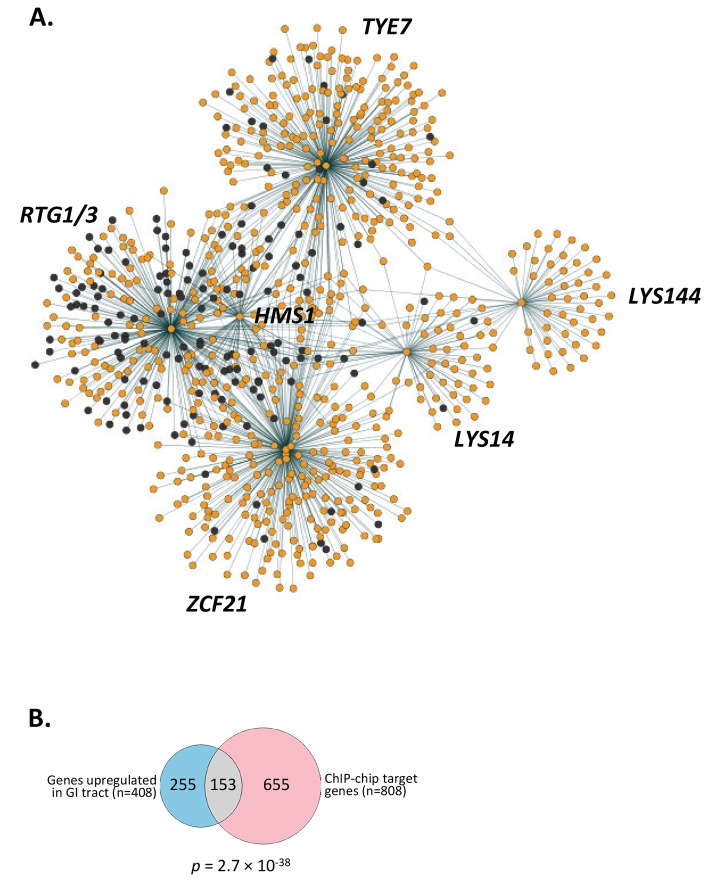
A gene regulatory network comprising C. albicans genes upregulated in the host.(A) Gene regulatory network depicting the established 808 target genes (orange circles) connected to their respective TRs (hubs) by dashed lines which indicate a direct interaction as determined by ChIP-chip. Dark grey circles correspond to the 153 genes upregulated in the GI tract. (B) A significant proportion of the target genes identified by ChIP-chip (n = 808) corresponds to genes upregulated when C. albicans grows in the GI tract (n = 408) [19]. The hypergeometric distribution was used to evaluate the significance of the overlap and its p-value is indicated.